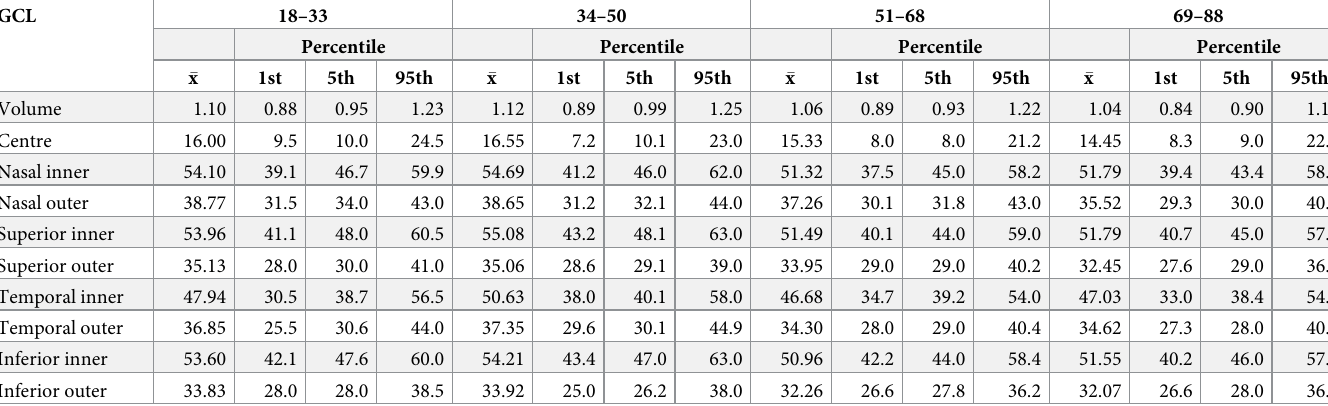
Table 6. Macular ganglion cell layer thickness distribution by age group, showing mean, first, fifth and 95th percentile values for each segment. GCL